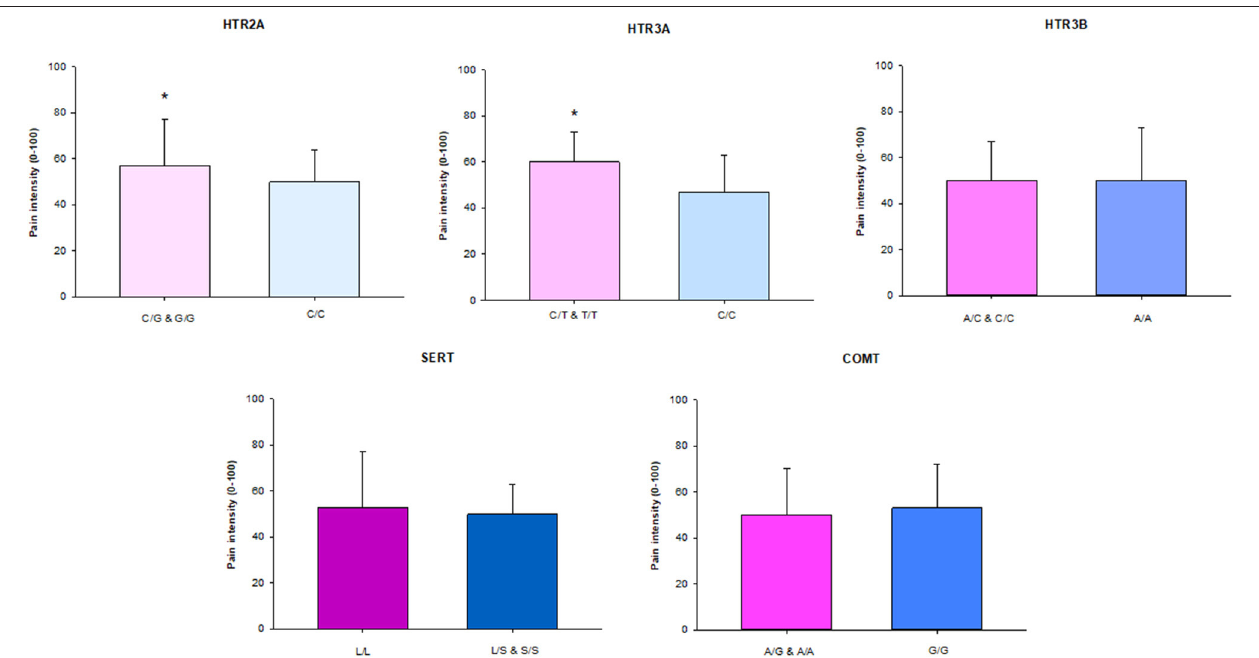
FIGURE 1 | The median (IQR) characteristic pain intensity (CPI) of the SNPs in HTR2A (rs9316233) , HTR3A (rs1062613) , HTR3B (rs1176744) , SERT (5-HTTLPR ), and COMT (rs4680) in 117 individuals with TMD myalgia (16 men and 101 women). A, adenine; C, cytosine; G, guanine; T, thymine; S, short allele; L, long allele. There was a significant difference (*) in HTR2A and HTR3A SNPs with significant higher pain intensity in patients with the homozygous rare genotype in combination with heterozygote compared to the homozygous common genotype ( P < 0.05).